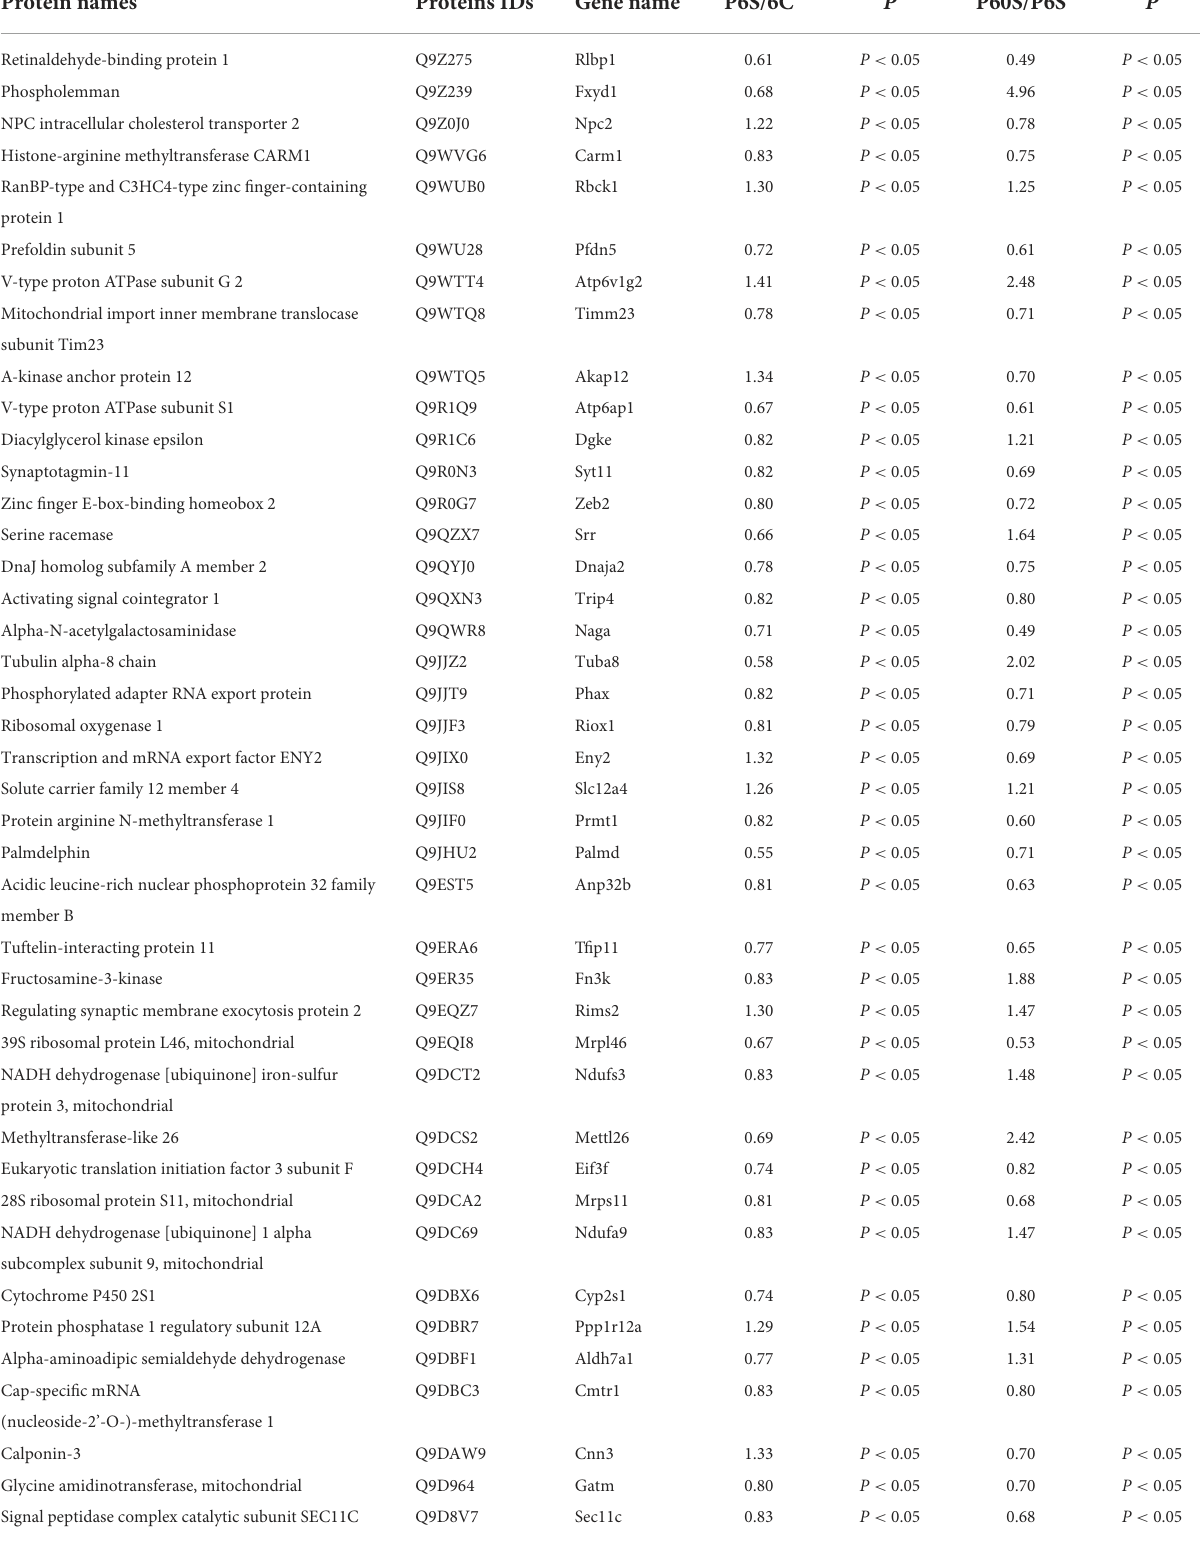
TABLE 3 List of the several sevoflurane-related significantly differential proteins in condition